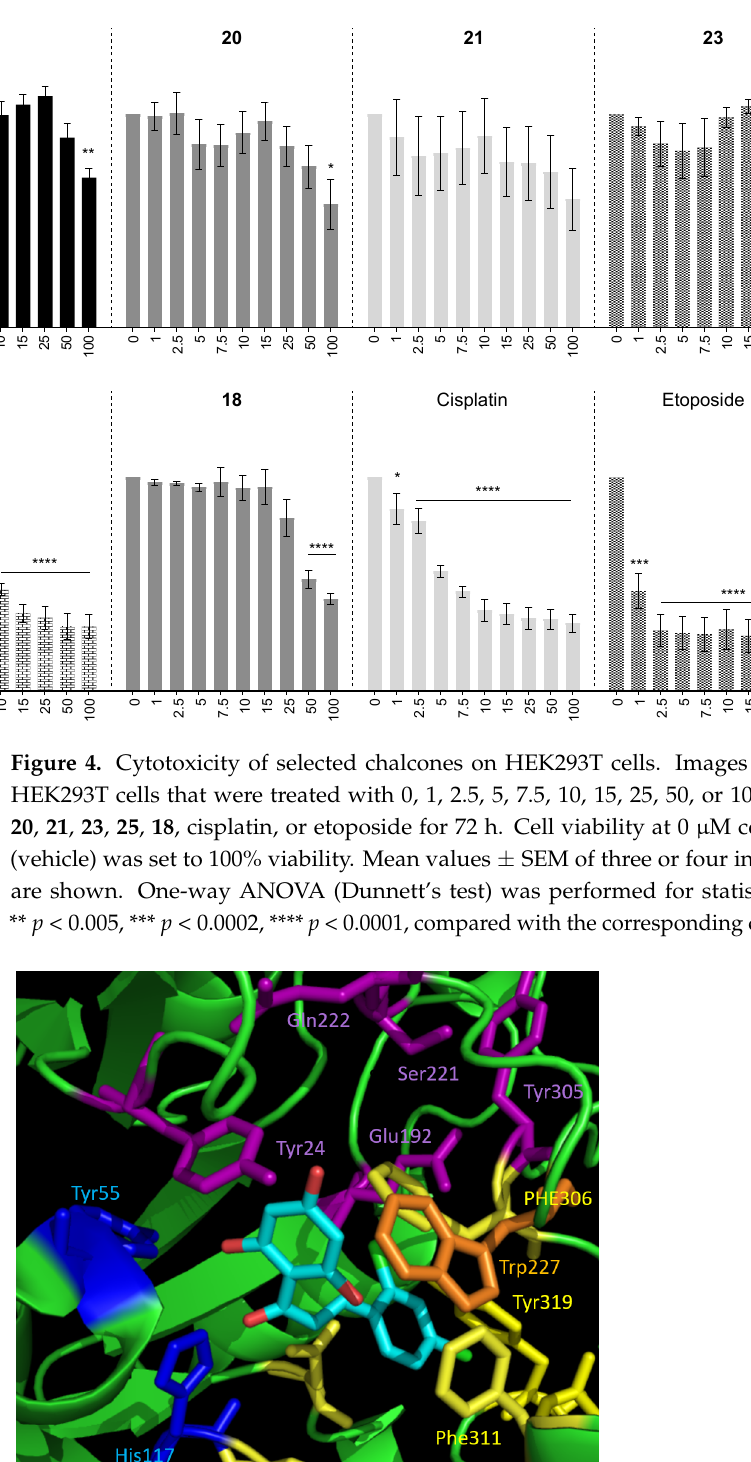
Figure 6. Localisation and orientation of chalcones to AKR1C3 in docking simulations: ( A ) docking pose of the protein (PDB Code: 3UWE) with its co-crystallised ligand 3-phenoxybenzoic acid (gray; IC 50 = 0.68 µM) and compound 23 (cyan), the compound with the highest inhibitory effect. The hydrophobic interactions between compound 23 and Tyr319 and Tyr216 are highlighted in yellow. The red and green arrows indicate hydrogen bonds between the hydroxy group of ring B of 23 and Tyr55 and His117, respectively; ( B ) shows the docking poses of the highly inhibiting chalcones 23